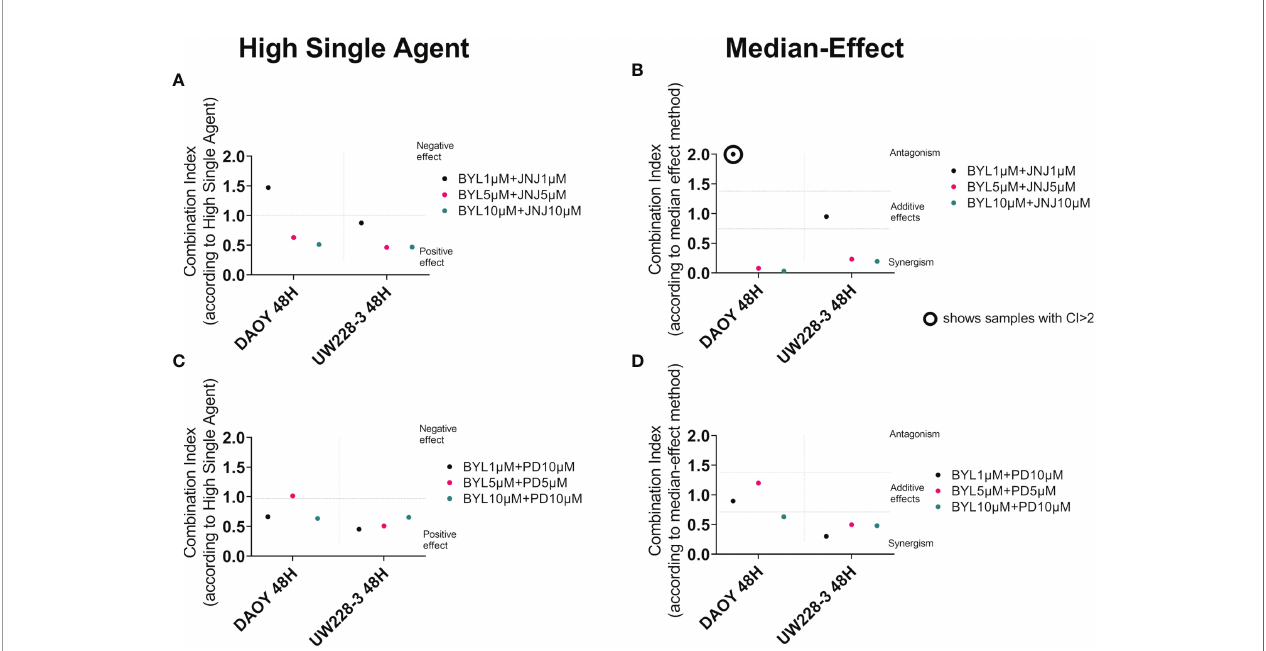
FIGURE 2 | Combination treatments with BYL719 and JNJ-42756493 and BYL719 and PD-0332991 in MB cell lines DAOY and UW228-3. Combination index (CI) analysis was calculated in MB cell lines treated for 48 h by using the Highest Activity Agent method [ (A) BYL719-JNJ-42756493 and (C) BYL719-PD-0332991] and the median-effect method (B, D) . In A and C charts, CI<1 indicates positive combination effect and CI>1 negative effect, while in B and D, CI<0.7 suggests synergy, CI>1.45 antagonism, and 0.7<CI>1.45 additive combinational effects. CIs were calculated from the means of three experiments, analyzed with